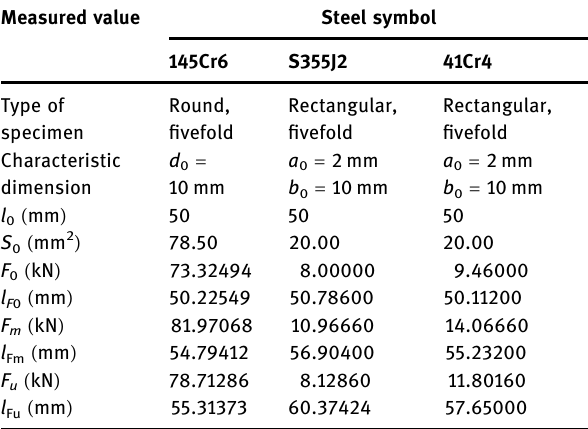
Table 1: The quantities necessary to determine selected material constants measured during experimental tests [ 9 – 12 ] ( selected